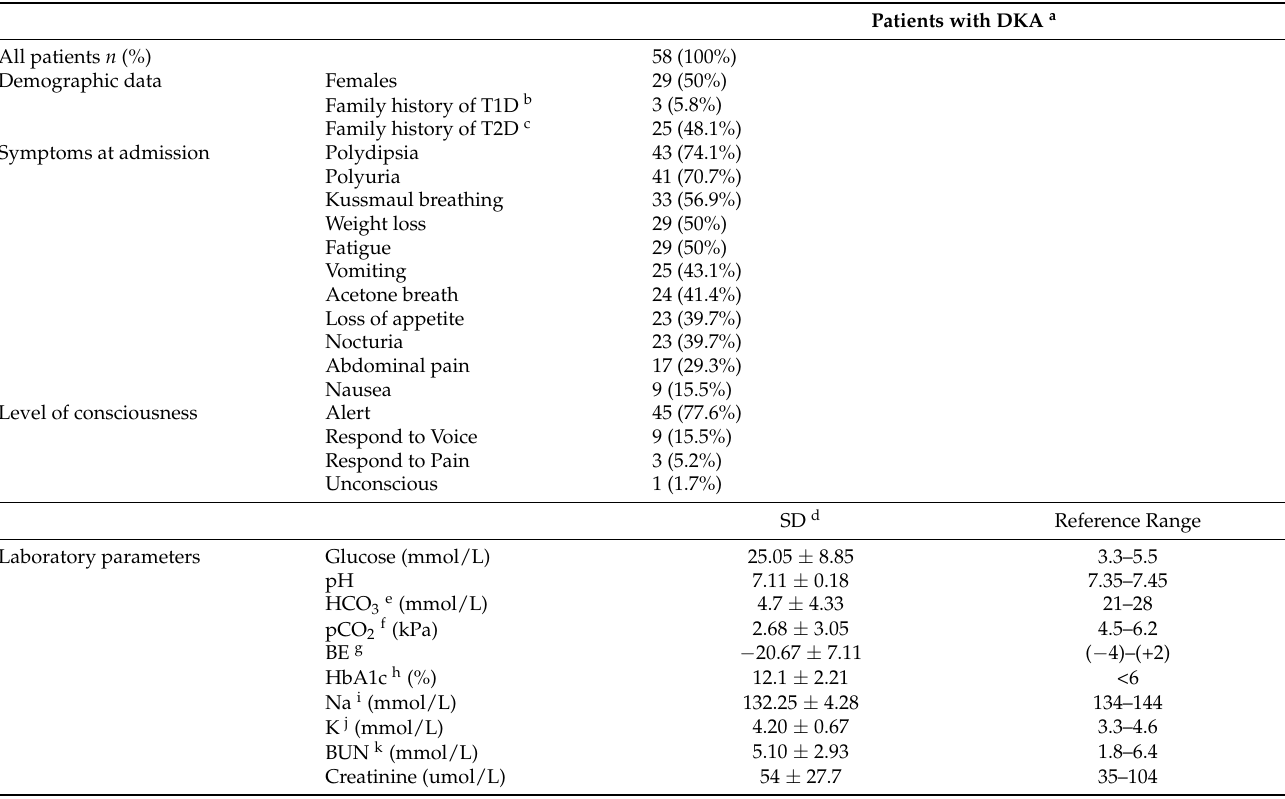
Table 1. Demographic, clinical and laboratory characteristics of children with diabetic ketoacidosis admitted to the Pediatric Intensive Care Unit at Clinical Hospital Centre Rijeka, Croatia, in the period